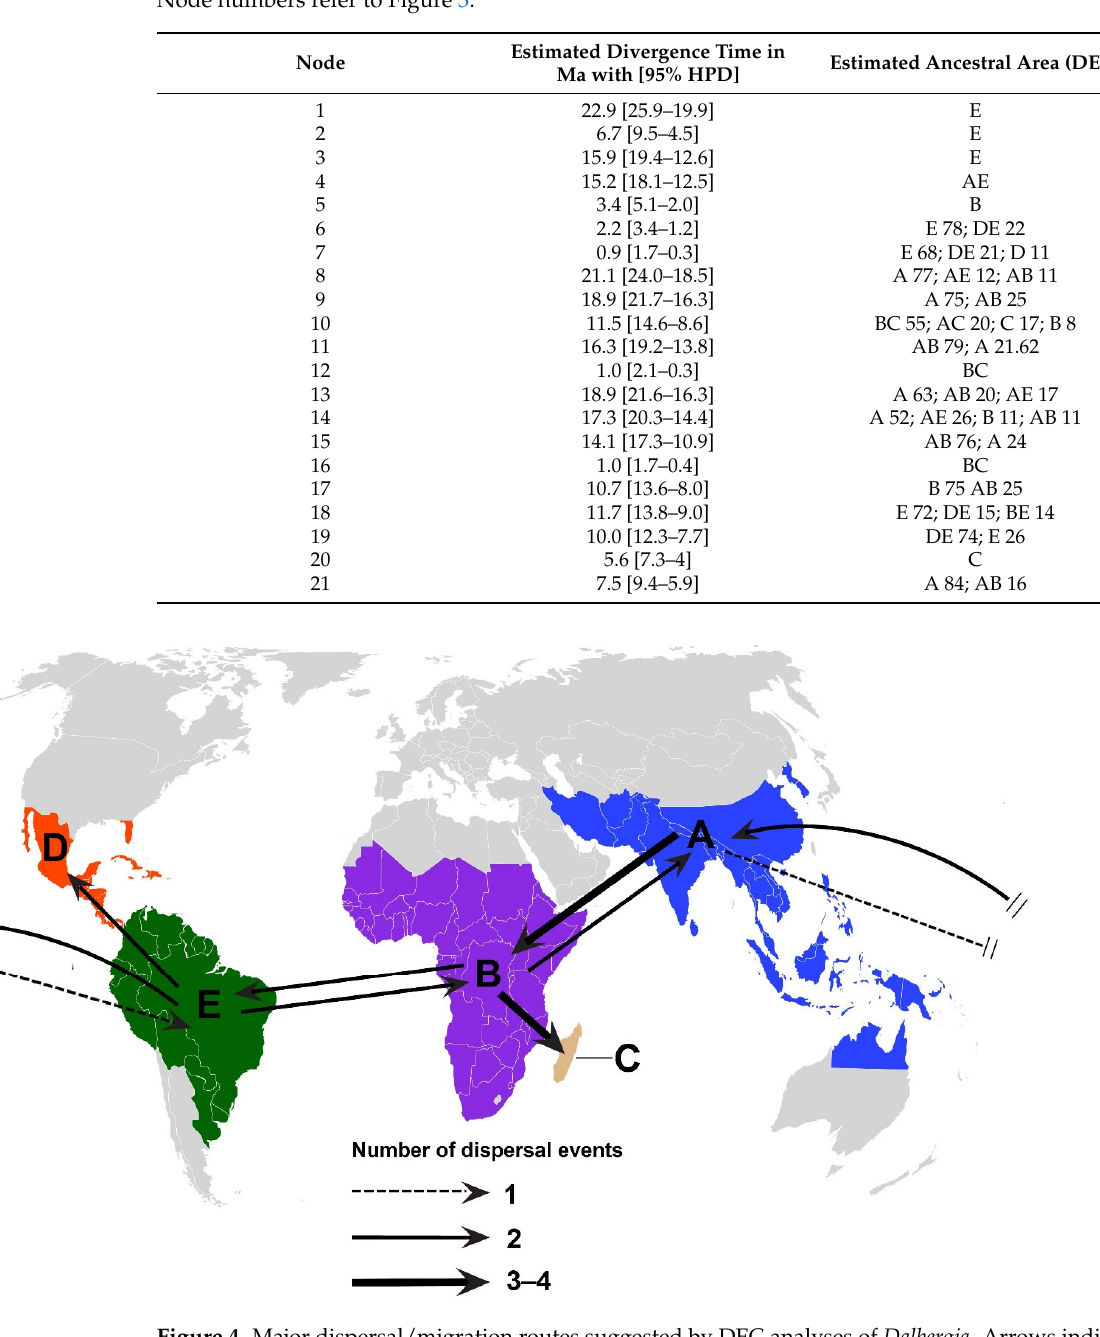
Table 3. Results of divergence time and ancestral area estimation for some major nodes in Dalbergia . The 95% highest posterior density (HPD) values of the divergence time estimations are provided in square brackets. The estimated ancestral areas of each node as inferred by BioGeoBEARS using the DEC model are shown, with rounded probabilities given as percentages. When only one area is shown, the probability is 100%. Areas are abbreviated as follows: A—Australasia; B—Africa; C—Madagascar; D—Central America (including Florida and the Caribbean); E—South America.